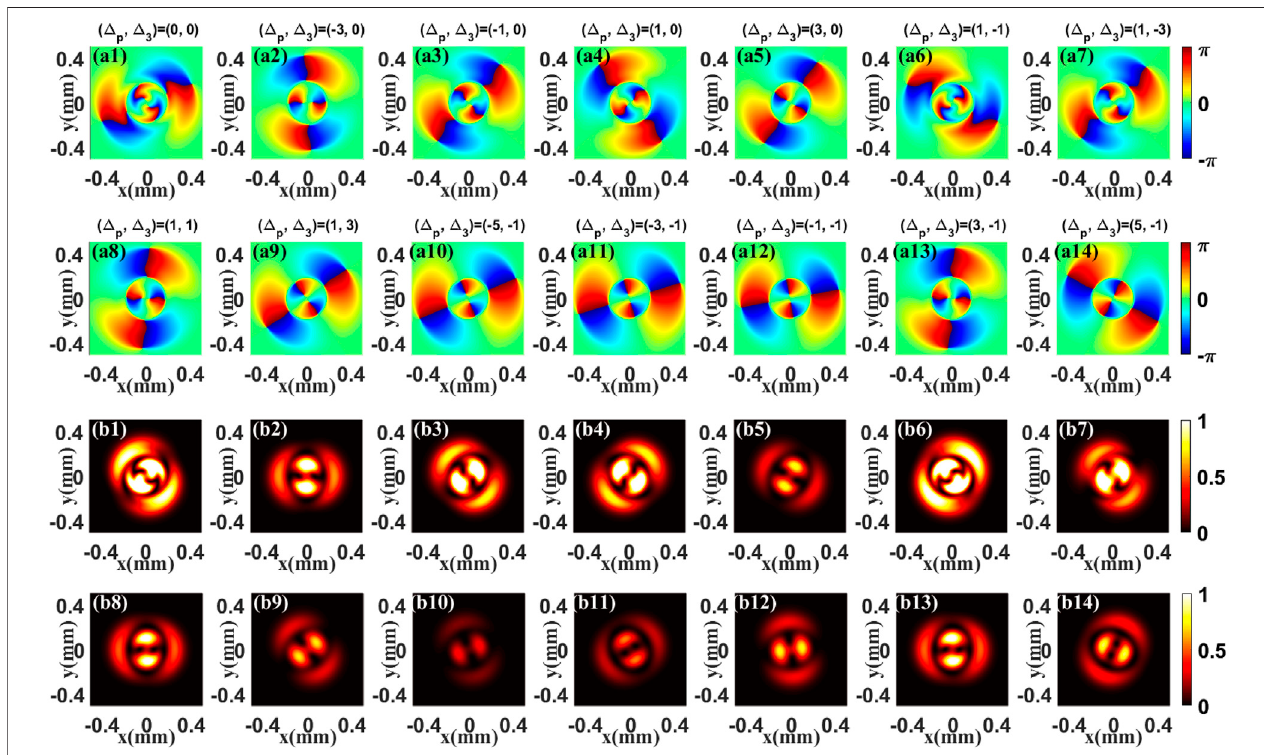
FIGURE 4 | Superposition phase (A1 – A14) and intensity (B1 – B14) patterns of FWM fi eld and the same-frequency Gaussian beam Ω G (cid:1) e −( r /2 ω 0 ) 2 for different Δ p and Δ 3 . The other parameters are the same as in Figure 2